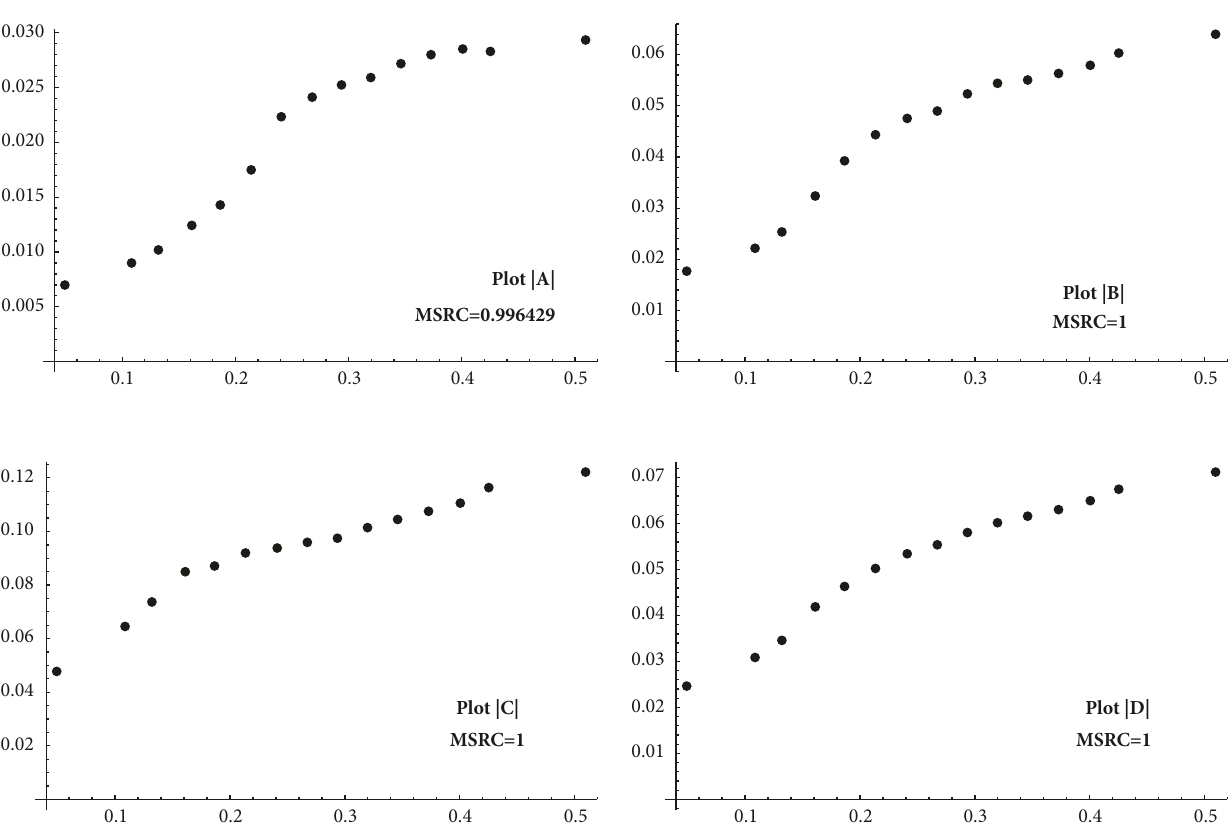
Figure 3: Performance of the new PCM-CM: TSL ( A ) . The plots present the relation between a mean value of TSL ( A ) within a given interval (VRCM n ) and quantiles of order 0.1 (Plot A), 0.5 (Plot B), and 0.9 (Plot C) of MAEs distribution as well as MAEs average values (Plot D) for estimated and true PVs. The results were generated with application of LLSM as the PP and Saaty’s scale. Plots are based on 10,000 random reciprocal PCMs for n